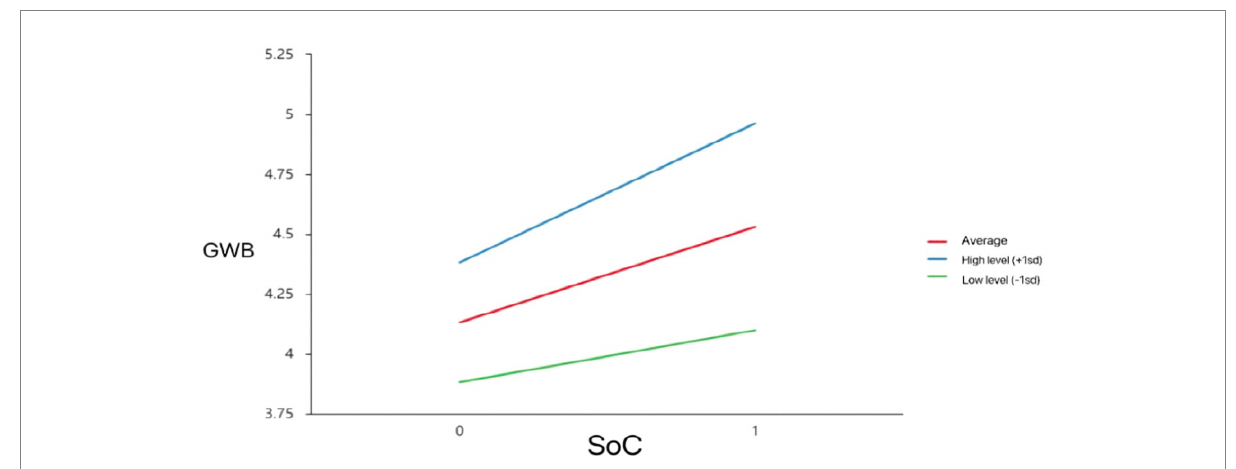
FIGURE 4 Model of test for simple slopes showing moderating influence of SS on association between SoC and